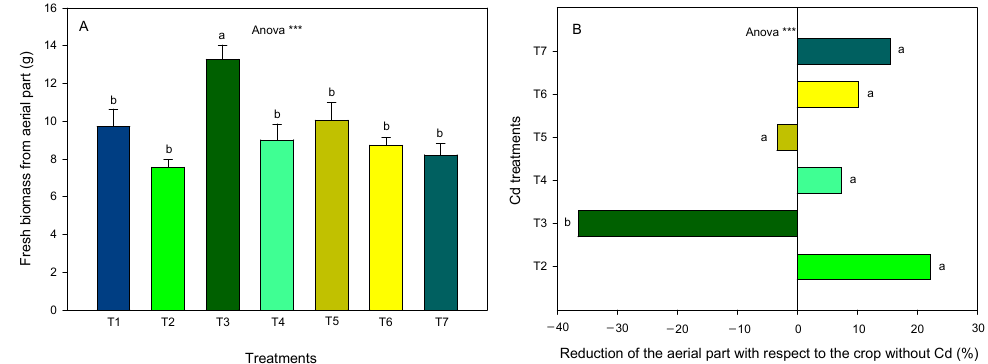
Figure 2. ( A ) Biomass of shoot (g Dw); and ( B ) percentage of reduction of this part with respect to T1 (NS) of plants grown under Cd toxicity conditions and treated with different active materials to mitigate this toxicity (T2: NS + Cd, T3: NS + Cd + BioG, T4: NS + Cd + Se1, T5: NS + Cd + Se2, T6: NS + Cd + chitosan1, and T7: NS + Cd + chitosan2). In the ANOVA: *** indicates significant differences at p < 0.001. When the ANOVA was significant, Tukey’s multiple range test was utilized to separate the means, where the different lower-case letters indicate significant differences between treatments. The vertical bars indicate the standard error of the mean (n = 4).